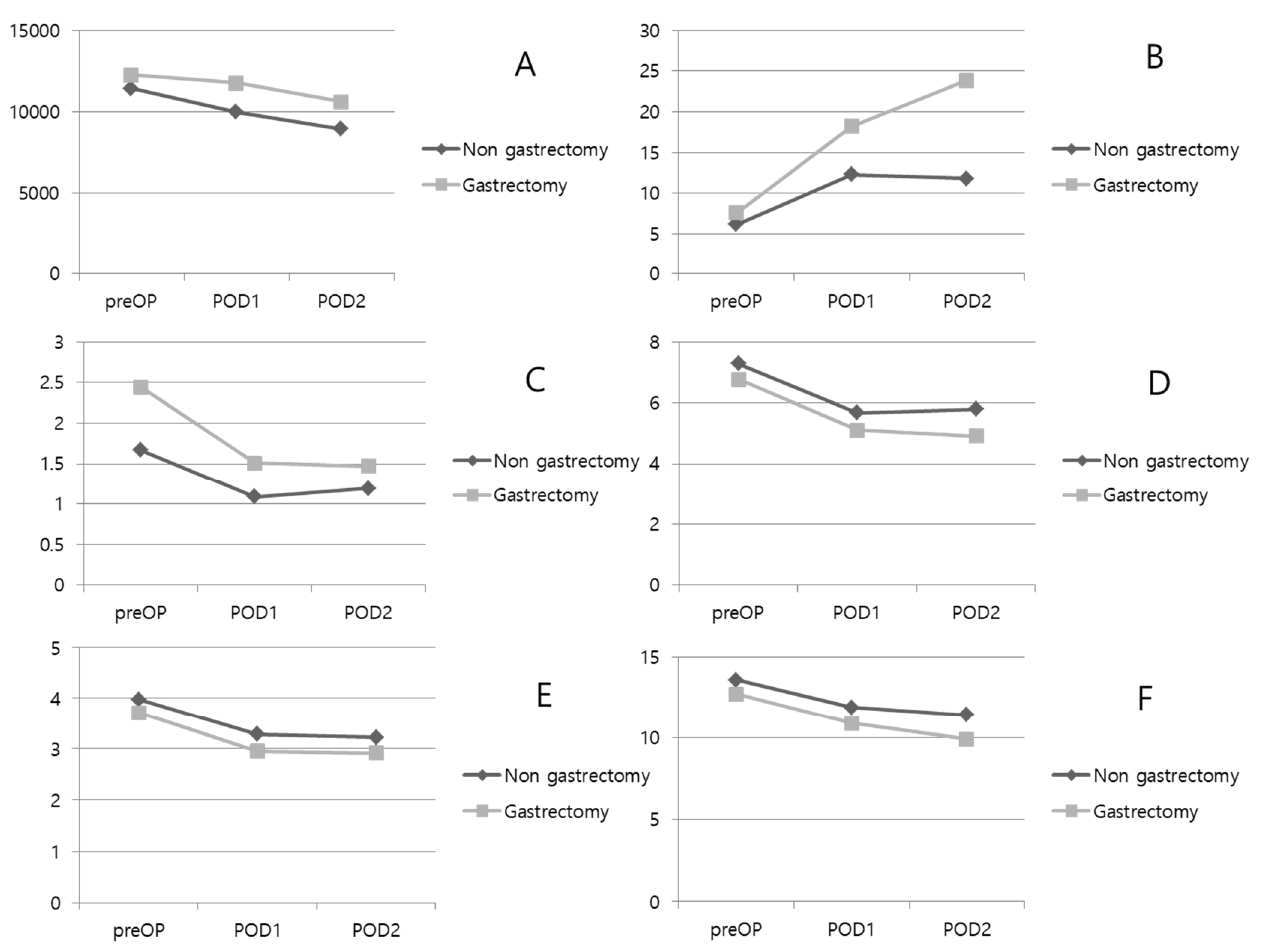
Figure 1. Perioperative laboratory results. ( A ): WBC. ( B ): CRP. ( C ): Total bilirubin. ( D ): Protein. ( E ): Albumin. ( F ): Hemoglobin. POD: postoperative day.